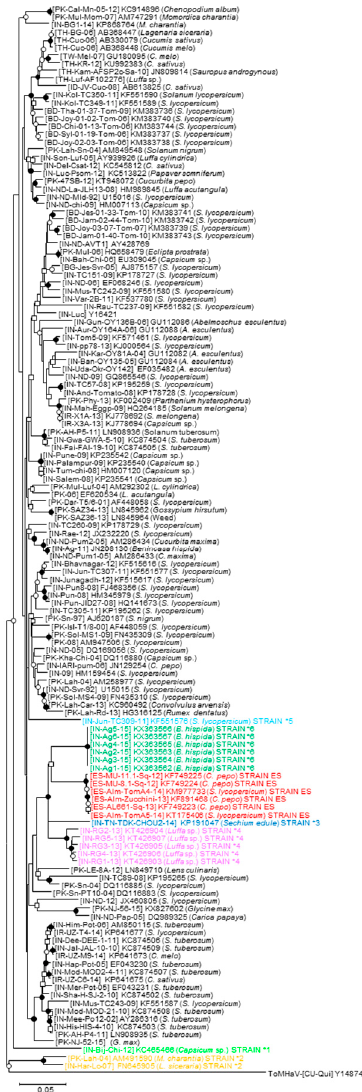
Figure 2. Phylogenetic relationships among DNA-A sequences of the tomato leaf curl New Delhi virus (ToLCNDV) isolates. Phylogenetic relationships among the full-length DNA-A sequences of 136 isolates of ToLCNDV available in the NCBI/GenBank and International Committee on Taxonomy of Viruses (ICTV) databases as of 10 July 2017. The tree was constructed using the neighbor-joining method with the MEGA 5.05 software program (http://www.megasoftware.net). Bootstrap (1000 replicates) analysis was performed and only the nodes with values greater than 50% are labeled, as follows: nodes supported in > 90% and > 70% of bootstrap replicates are marked with filled and open circles respectively, and those with values greater than 50% are marked with open squares. Isolates that differed at the strain threshold level according to criteria for species/strain demarcation currently accepted for begomoviruses by the ICTV [37] (marked with asterisks in Supplementary Materials Table S1) are highlighted with colored letters. Scale bar indicates 0.05 nucleotide substitutions per site. Virus species, GenBank accession number and plant host are indicated for each isolate included in the analysis. The sequence of the DNA-A of isolate (CU-Qui) of the bipartite begomovirus species tomato mosaic Havana virus (ToMHaV) (GenBank accession number Y14874) was included as an